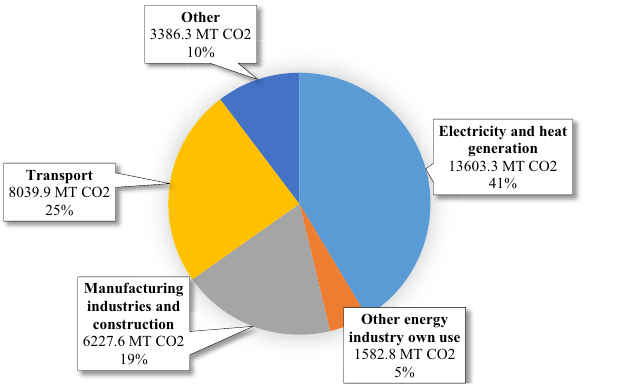
Figure 3. CO2 emissions